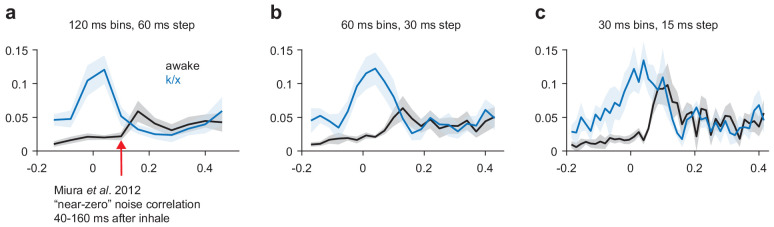
Noise correlations in awake and anesthetized PCx.(a–c) Average noise correlations in a sliding window surrounding odor inhalation for all awake (black) or k/x (blue) odor trials using a 120 ms (a), 60 ms (b) or 30 ms (c) bin size for spike counts. Mean ± s.e.m, n = 11 experiments.